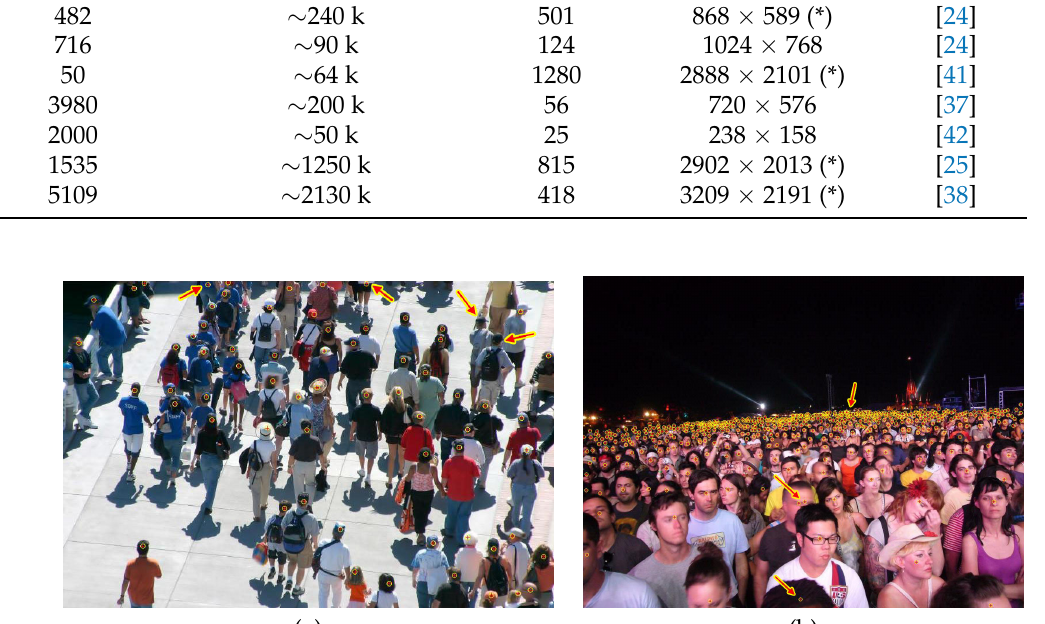
Table 1. Main specifications of crowd counting datasets. Datasets with varying image size are marked as (*). Dataset